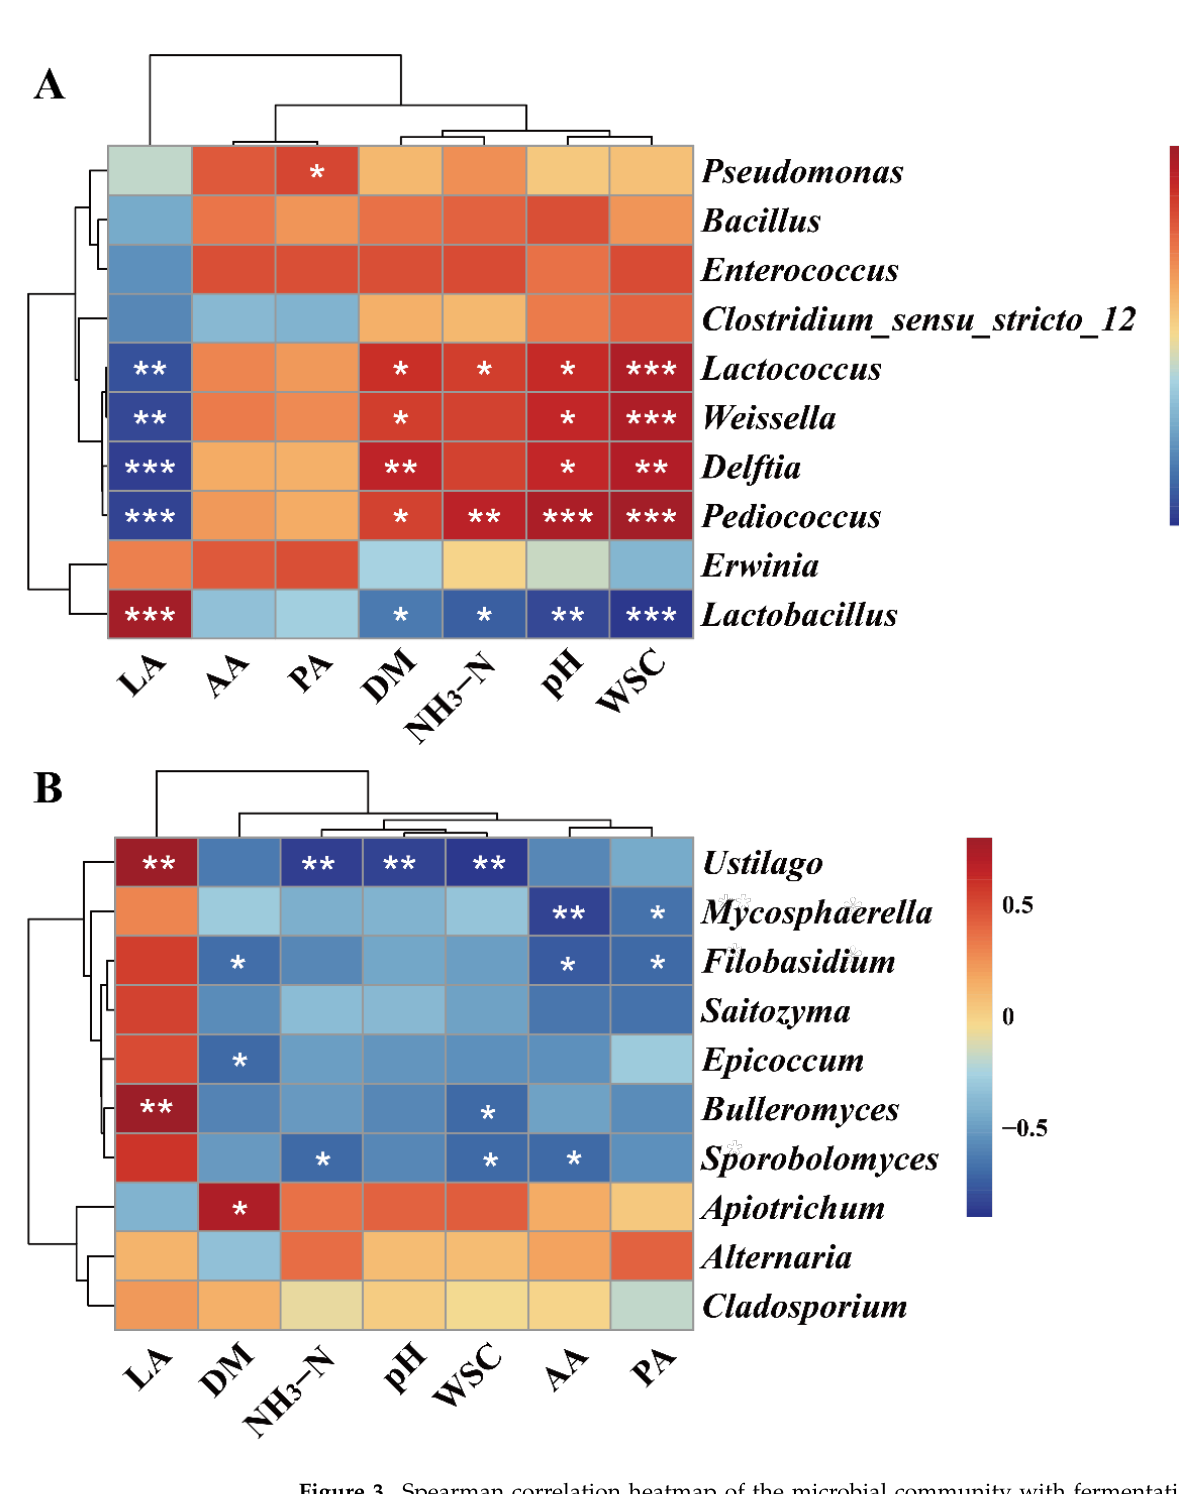
Figure 3. Spearman correlation heatmap of the microbial community with fermentation charac- teristics at the genus level. ( A ) Correlation between dominant bacterial genera and fermentation characteristics; ( B ) Correlation between dominant fungal genera and fermentation characteristics. A positive correlation is indicated in red color, and a negative correlation is indicated in blue. * Indicates significance at p < 0.05, ** indicates significance at p < 0.01, and *** indicates significance at p < 0.001.